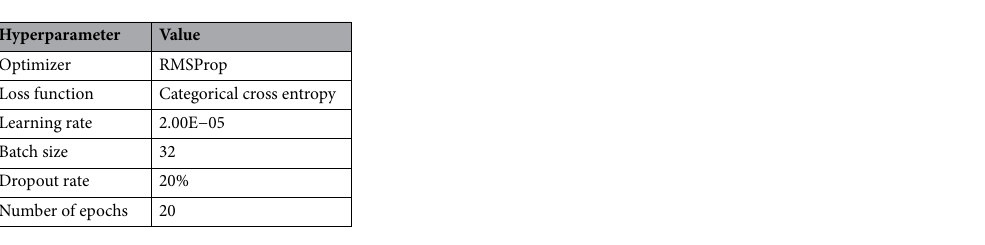
Table 1. Values of the hyperparameters used for training the base CNN